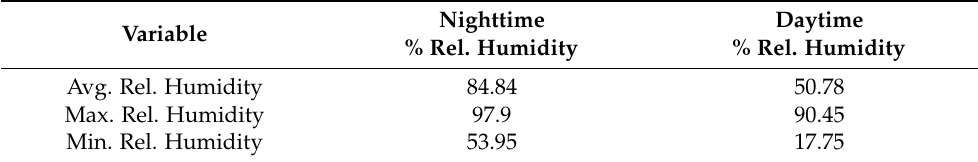
Nighttime % Rel. Humidity